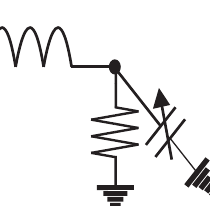
Figure 1. Schematic of a single nonlinear oscillator. This oscillator is the basic building block of the networks considered in this paper. The circuit contains one inductor, one voltage-dependent capacitor, one source, and one